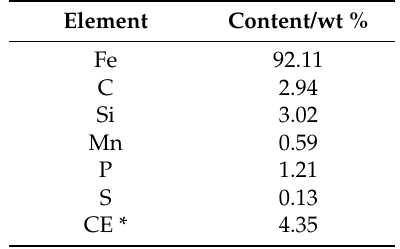
Table 2. The composition of the cast